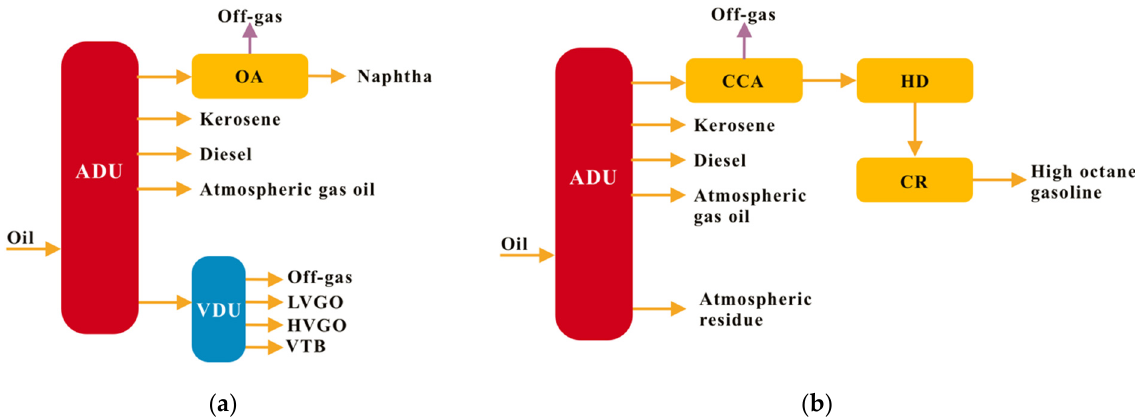
Figure 2. Schemes of mini-refineries PT Tri Wahana Universal ( a ) and PT Humpuss Pengolahan Minyak ( b ).